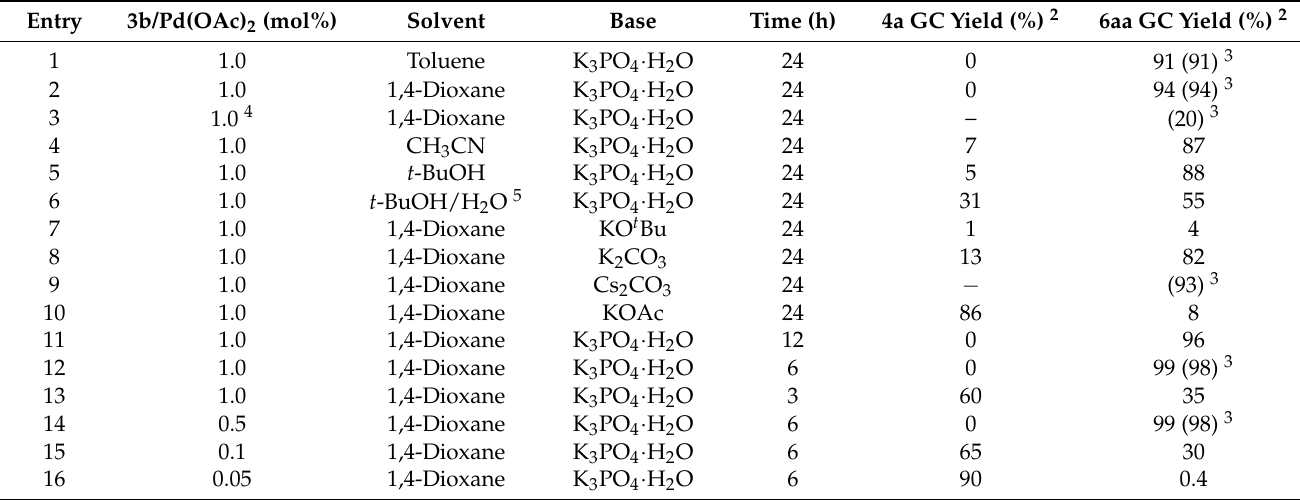
Table 2. Optimization of reaction conditions 1 .